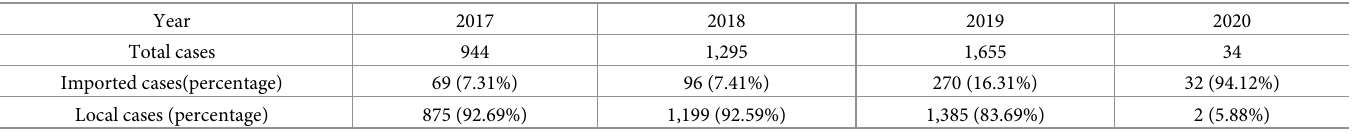
Table 1. Numbers and percentages of dengue cases from 2017 to